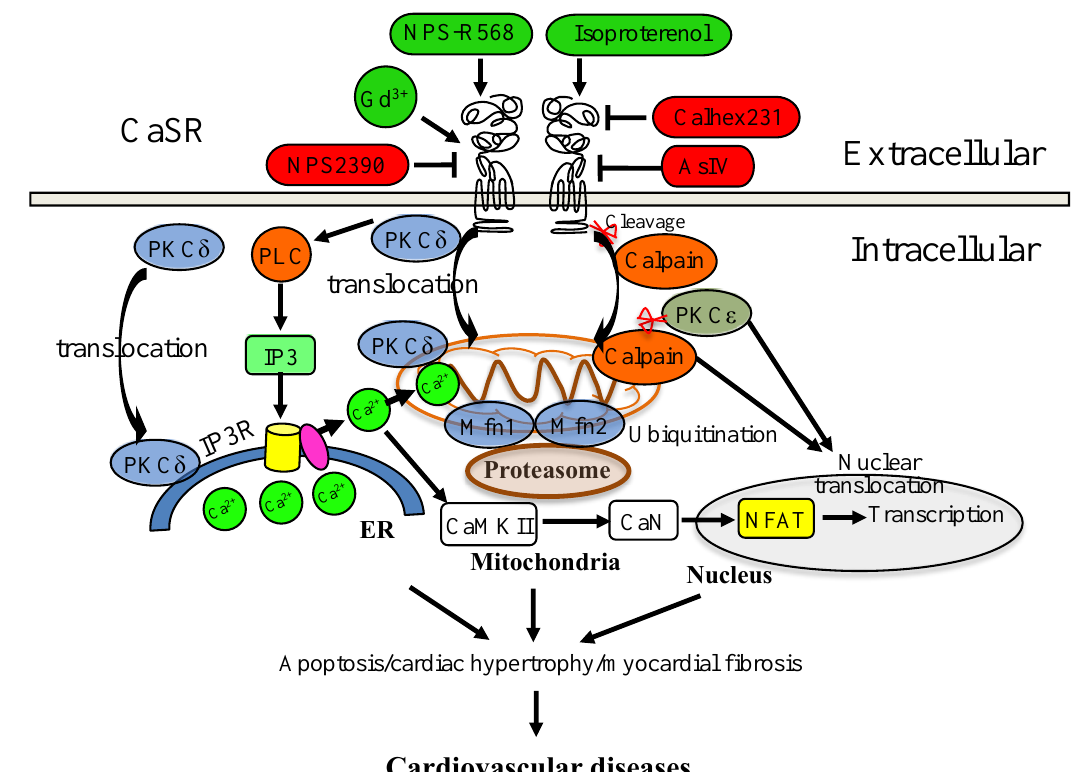
Figure 1. CaSR signaling mediates cardiovascular diseases. The activation regulator is in red color, and the negative modulator is in green color.